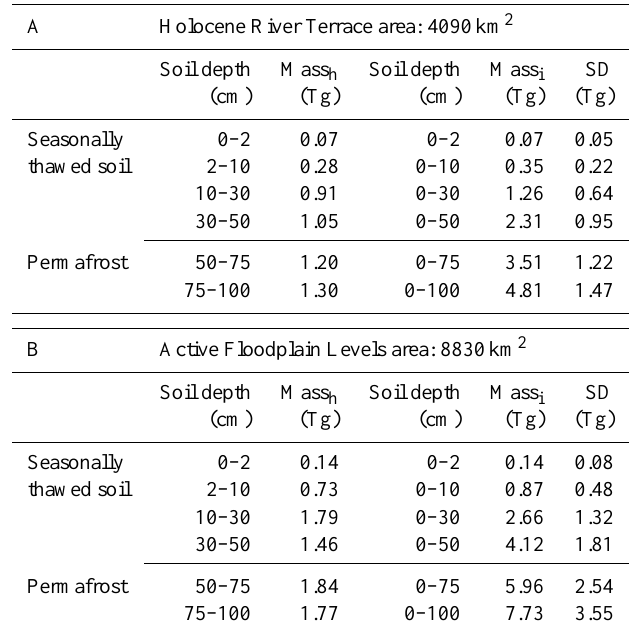
Table 9. The vertical distributions of the total nitrogen mass within the seasonally thawed and perennially frozen soil for the Holocene river terrace (A) and the active floodplain levels (B) in the Lena River Delta. Represented are the estimated mean total nitrogen mass (Tg) for all investigated soil horizons (Mass h ) and the estimated mean total nitrogen mass (Tg) for different depth increments (Mass i ) with the respective standard